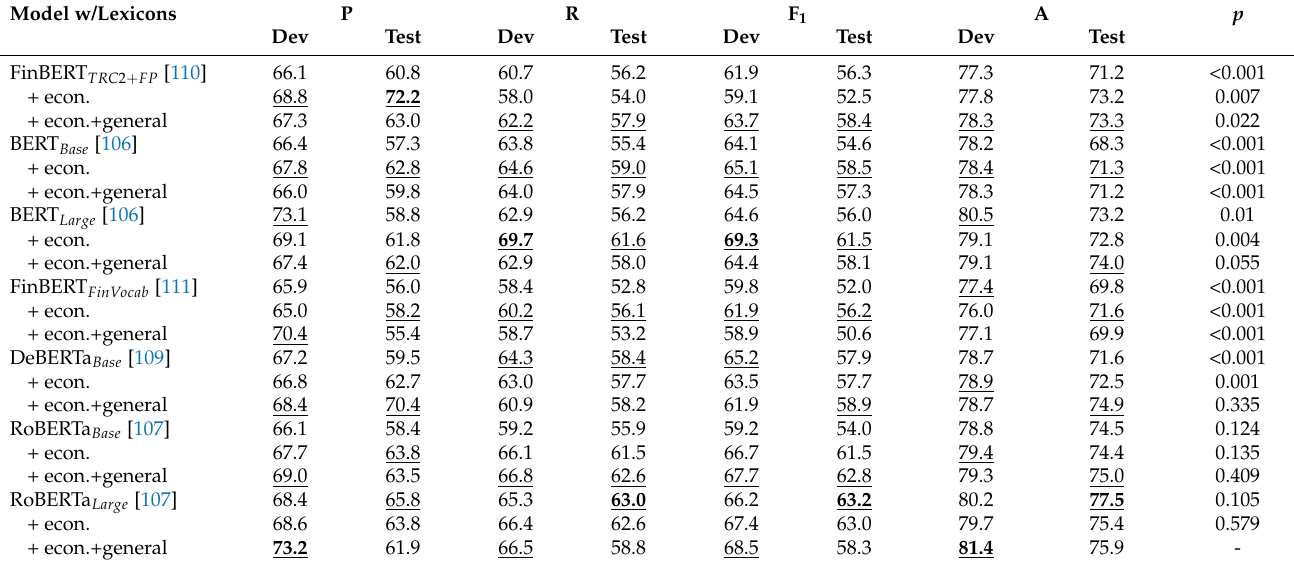
Table 6. Implicit sentiment polarity classification results of gold polar expressions on development set (dev) and holdout set (test). Precision (P), recall (R), andd F 1 -score (F 1 ) percentages are macro-averaged. Winning models selected on dev accuracy after optimizing hyperparameters for each architecture ablation. Accuracy (A) is reported with the p -value of McNemar’s significance test of predictions with respect to the winning model. Boldface type indicates highest score overall and underlining indicates the highest score within encoder